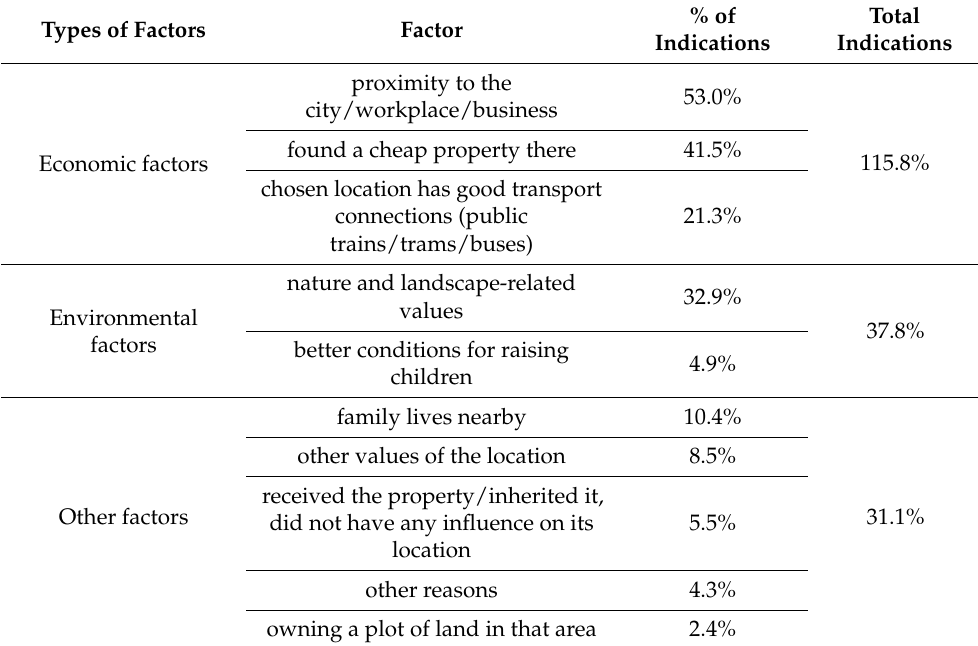
Table 2. Reasons for choosing a specific location (village) broken down into economic, environmental, and